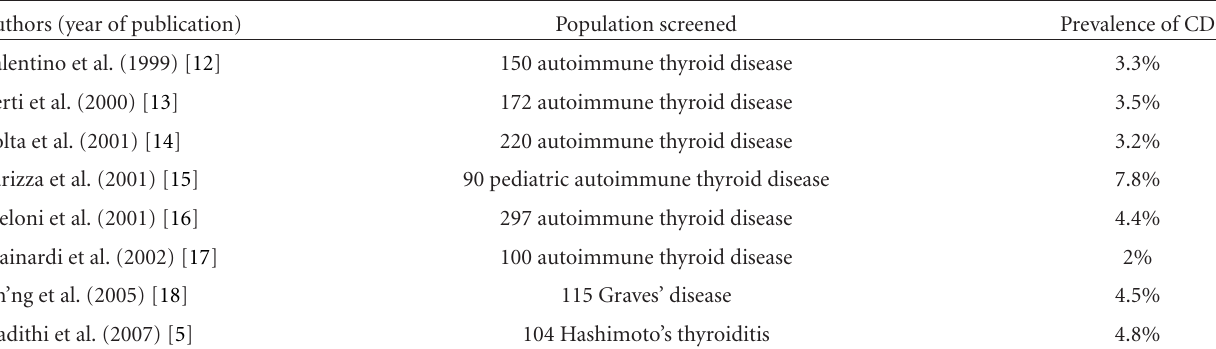
Table 3: Prevalence of celiac disease (CD) in autoimmune thyroid disease.